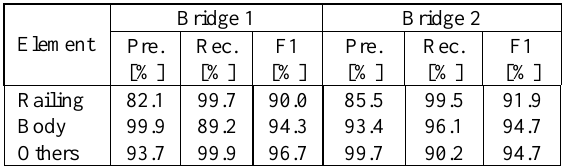
Table 3. Accuracy evaluation of segmentation.